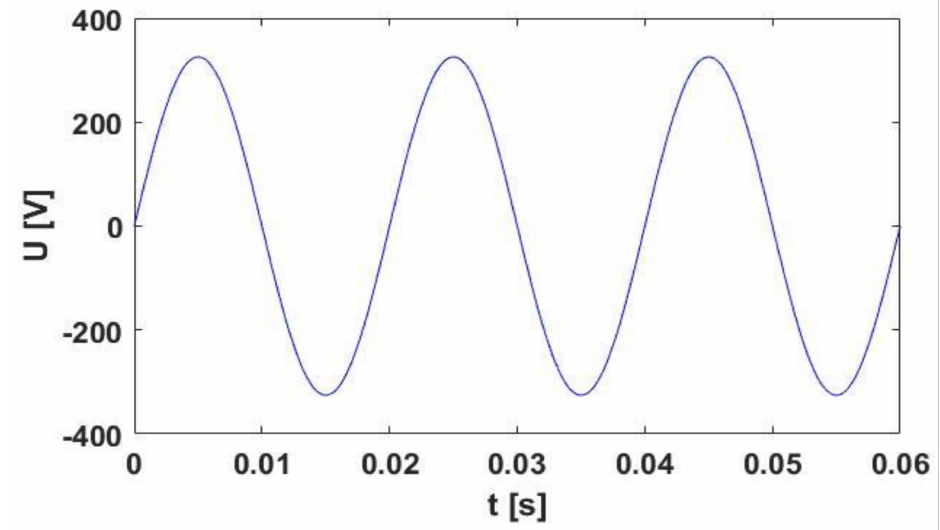
Figure 6. Input voltage waveform in the microinverter section.